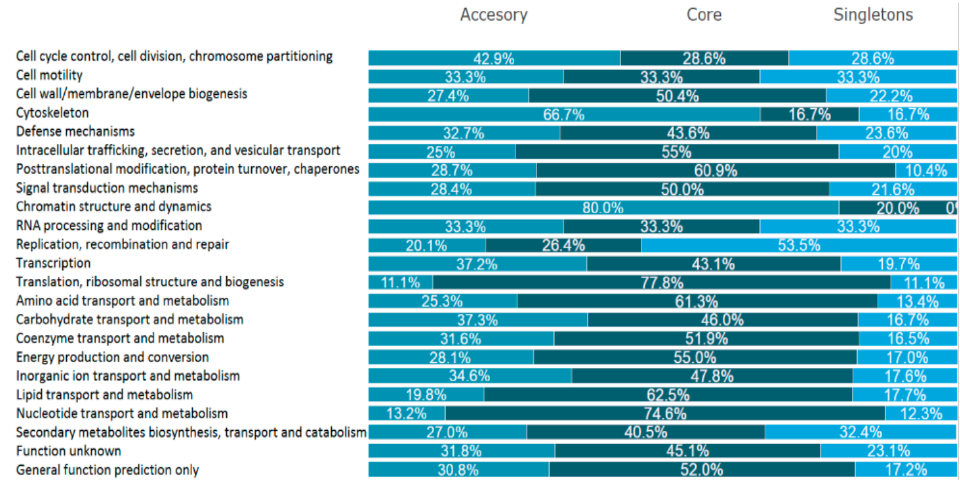
Figure 5. Distribution of clusters of orthologous groups of proteins (COGs) among accessory, core and singleton gene